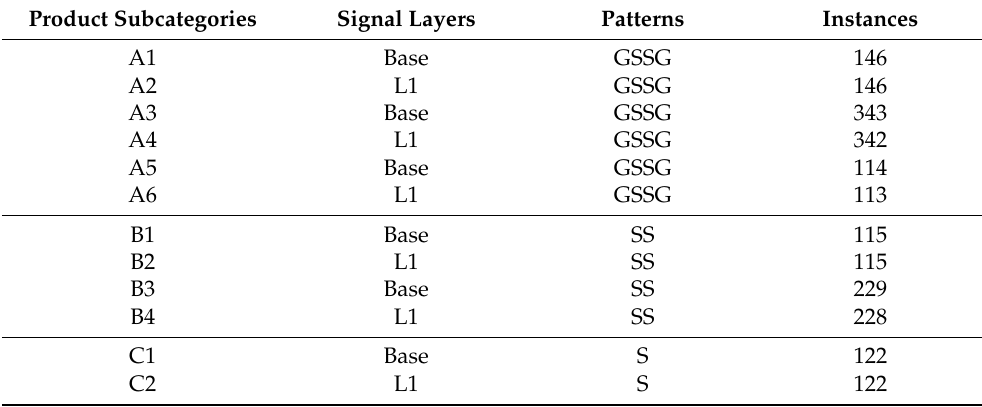
Table 3. The datasets for product subcategories based on the signal layers and patterns.